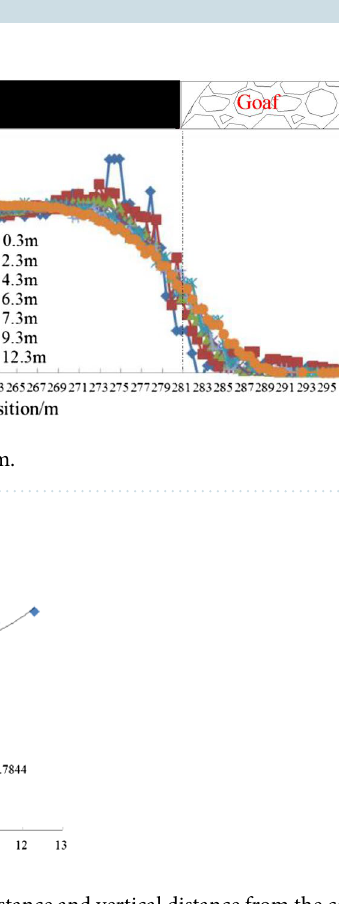
Figure 6. The relationship of the roadway horizontal distance and vertical distance from the coal